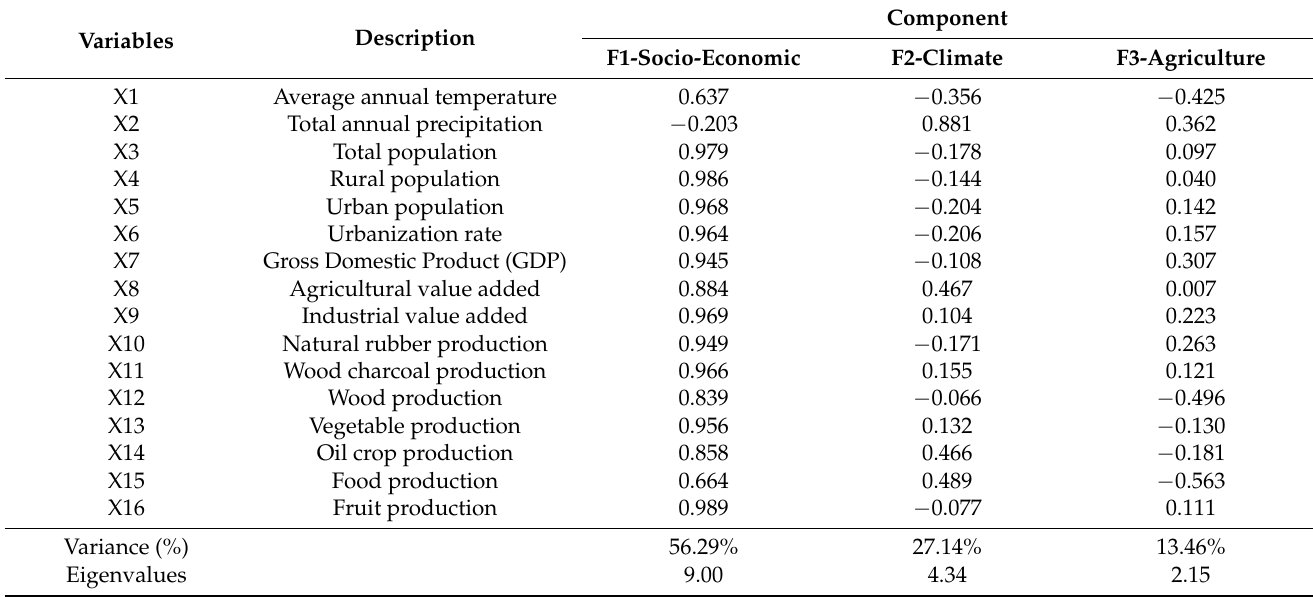
Table 4. Component matrix of the principal component